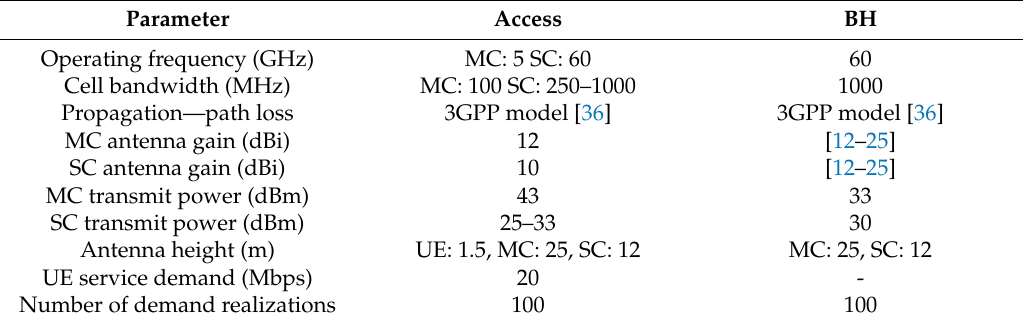
Table 1. Simulation parameters for access and BH